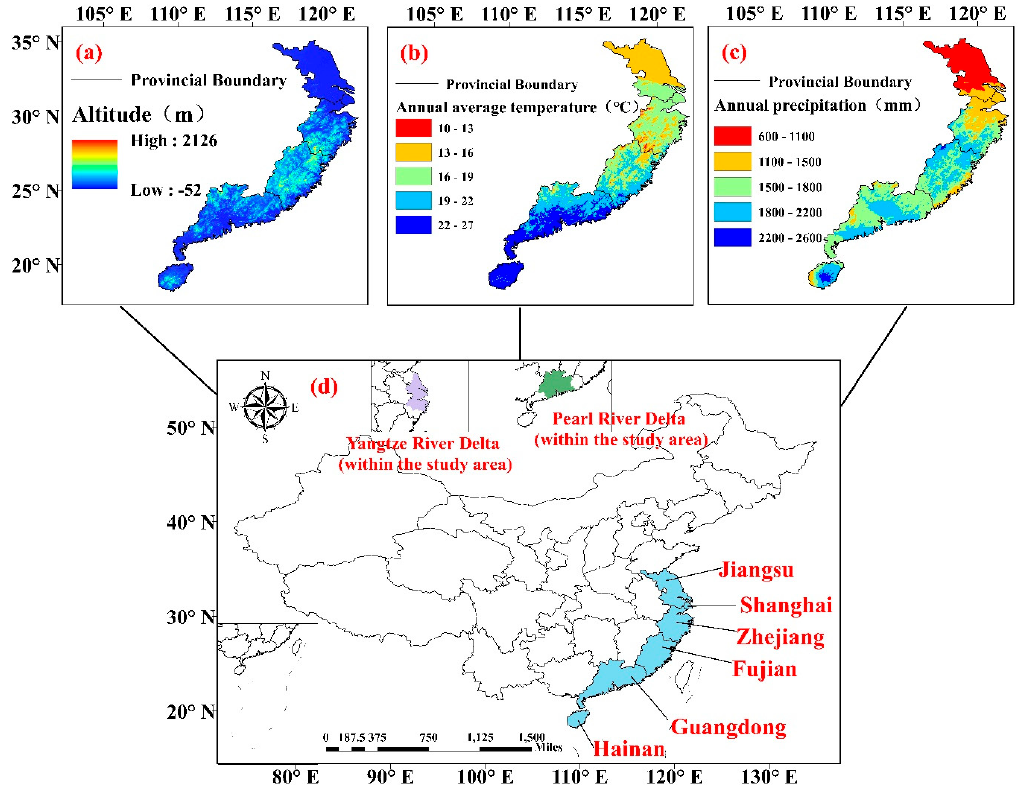
Figure 1. Study area: ( a ) elevation, ( b ) average temperature, ( c ) precipitation, and ( d ) location of the study area in